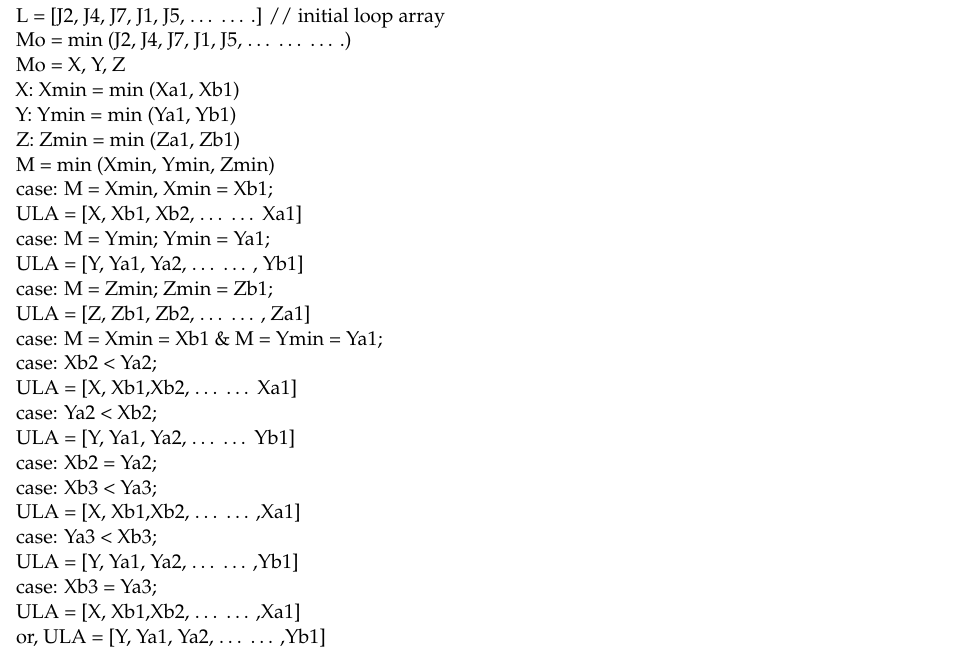
Algorithm 2 . Code structure for determining the unified loop array, ULA, for multiple master